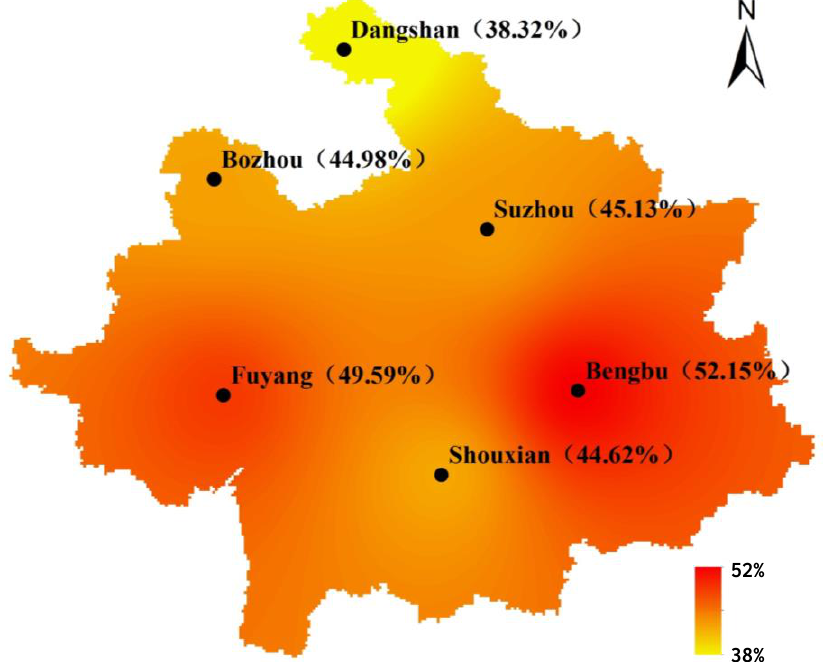
Figure 3. The Spatial distribution of probability for days with T max ≥ 33 °C during the flowering stage in six sites, i.e., Shouxian, Bengbu, Fuyang, Suzhou, Bozhou, and Dangshan, on Huaibei Plain, China.